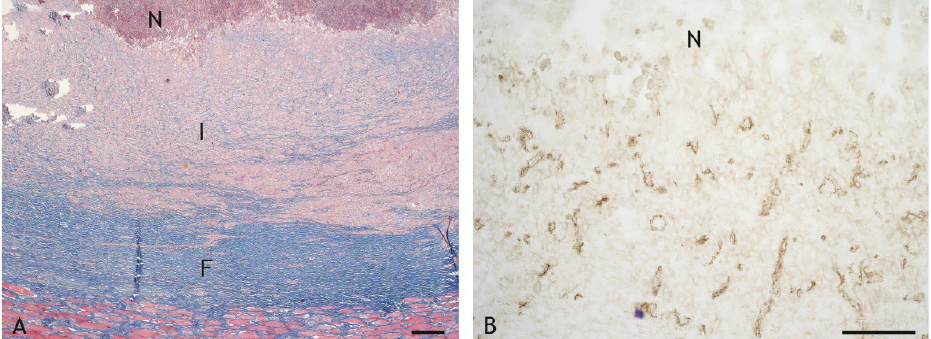
Figure 9. Fibrous connective tissue capsule ( A ) and vascularization ( B ) in VPM1002-induced gran- ulomas (N–central necrosis). ( A ). Fibroblasts and collagen fibers (blue) form a thick capsule (F)